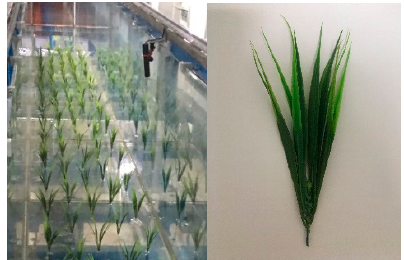
Figure 2. The layout and shape of plants.